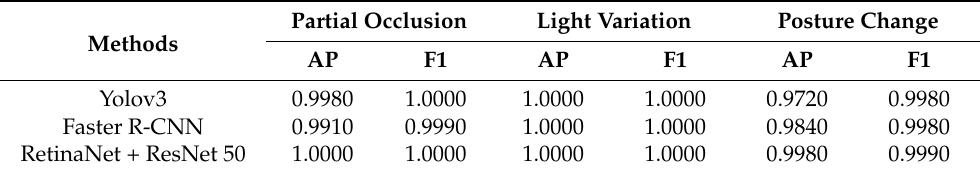
Table 3. Comparison of detection results under different conditions.